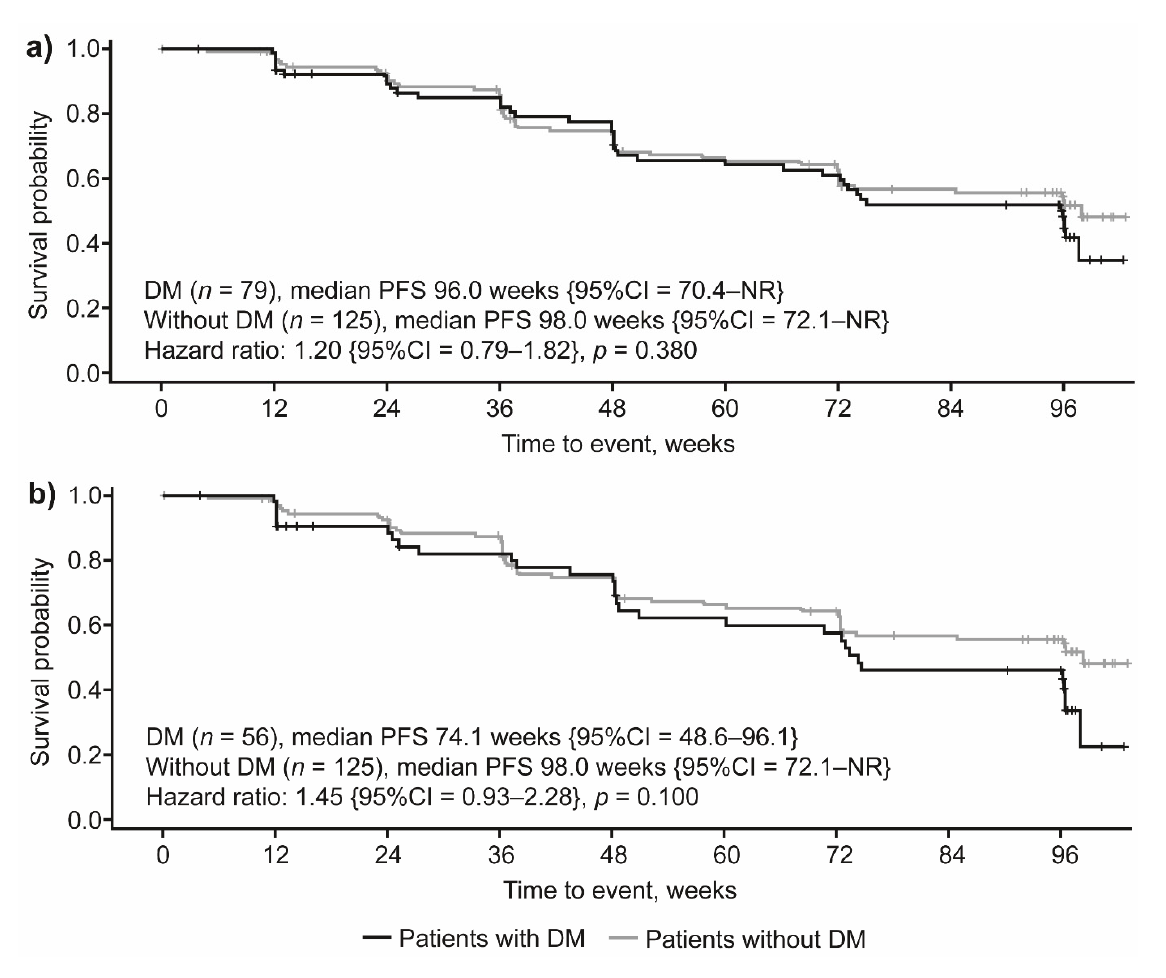
Figure 2. PFS by DM status in ( a ) all patients and ( b ) excluding patients diagnosed with DM after study treatment initiation. CI, confidence interval; DM, diabetes mellitus; NR, not reached; PFS, progression-free survival.